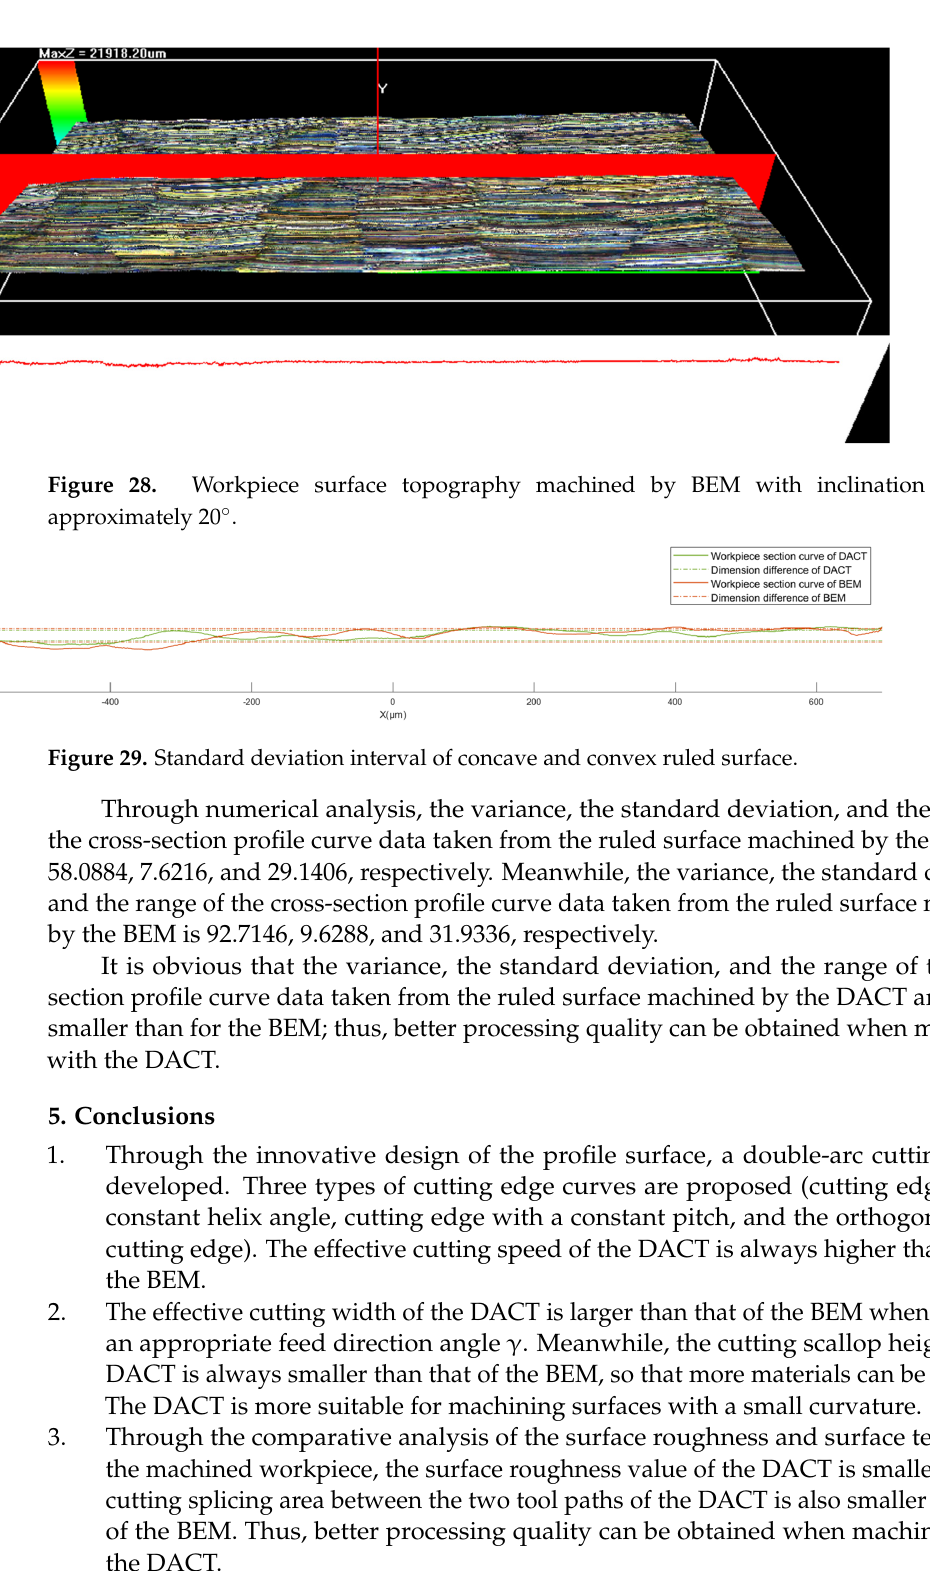
Figure 27. Workpiece surface topography machined by DACT with inclination angle of approxi-